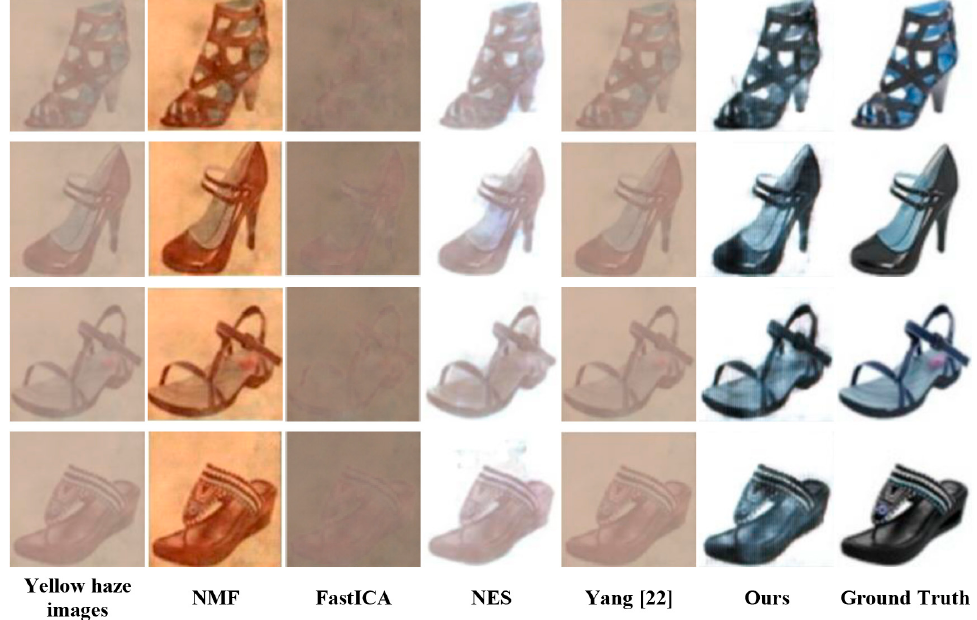
Figure 4. Results of image separation for the yellow haze images.